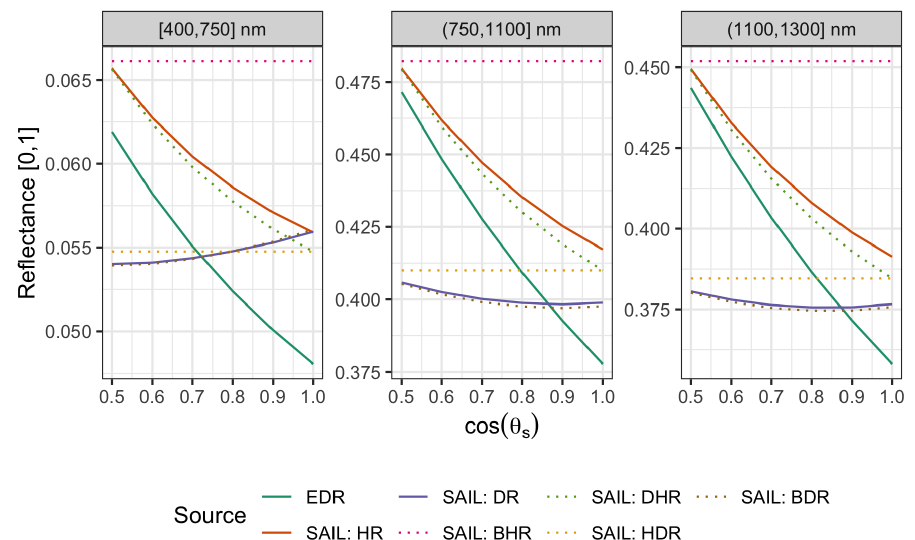
Figure 10. Comparison of EDR and PRO4SAIL (labeled as “SAIL” for conciseness) predictions of reflectance for identical, single-cohort canopies as a function of solar zenith angle ( θ s ). These simulations use identical PROSPECT and canopy structure parameters, a nadir- viewing sensor, and LAI of 3. For EDR, we use a single cohort with LAI of 3 prescribed directly. “SAIL: HR” is the “hemispherical reflectance” (“blue-sky albedo”), calculated (as in EDR) as the average of directional–hemispherical reflectance (DHR) and BHR streams weighted by the direct sky fraction (0.9; same value used for EDR). Similarly, “SAIL: DR” is the “directional reflectance”, calculated analogously from the bi-directional reflectance (BDR) and hemispherical–directional reflectance (HDR) streams. Individual SAIL fluxes are shown with dotted